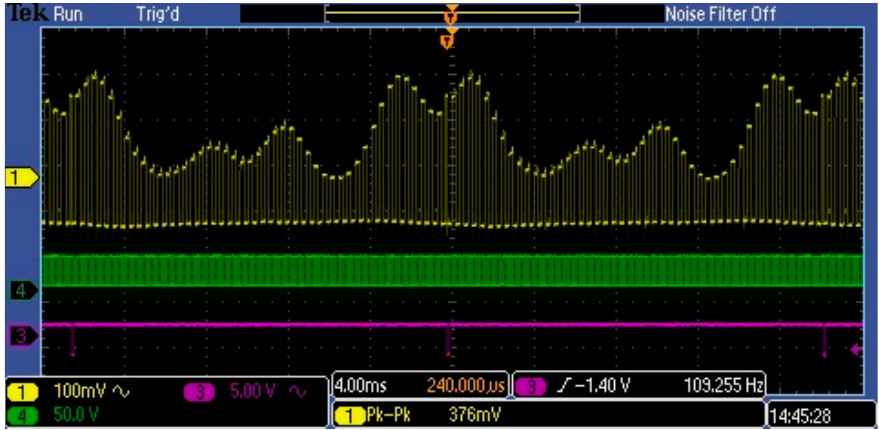
Figure 11. Measured MEMS waveforms when the video contains only the variable component.